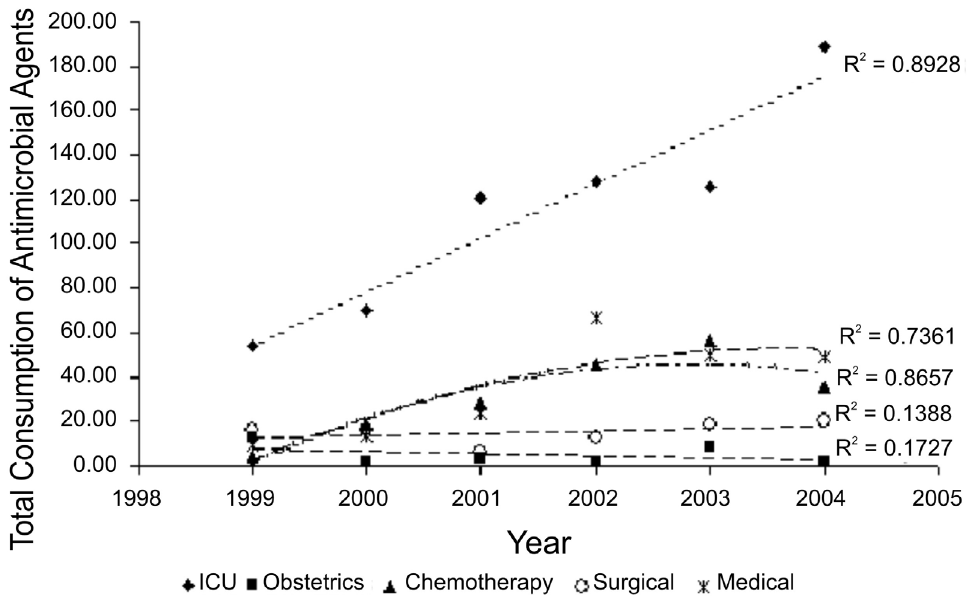
FIGURE 1 – Monthly average of total consumption of selected antimicrobial agents (expressed in DDDs/100 patients-day) utilized per admission unit of HUOP, in the study